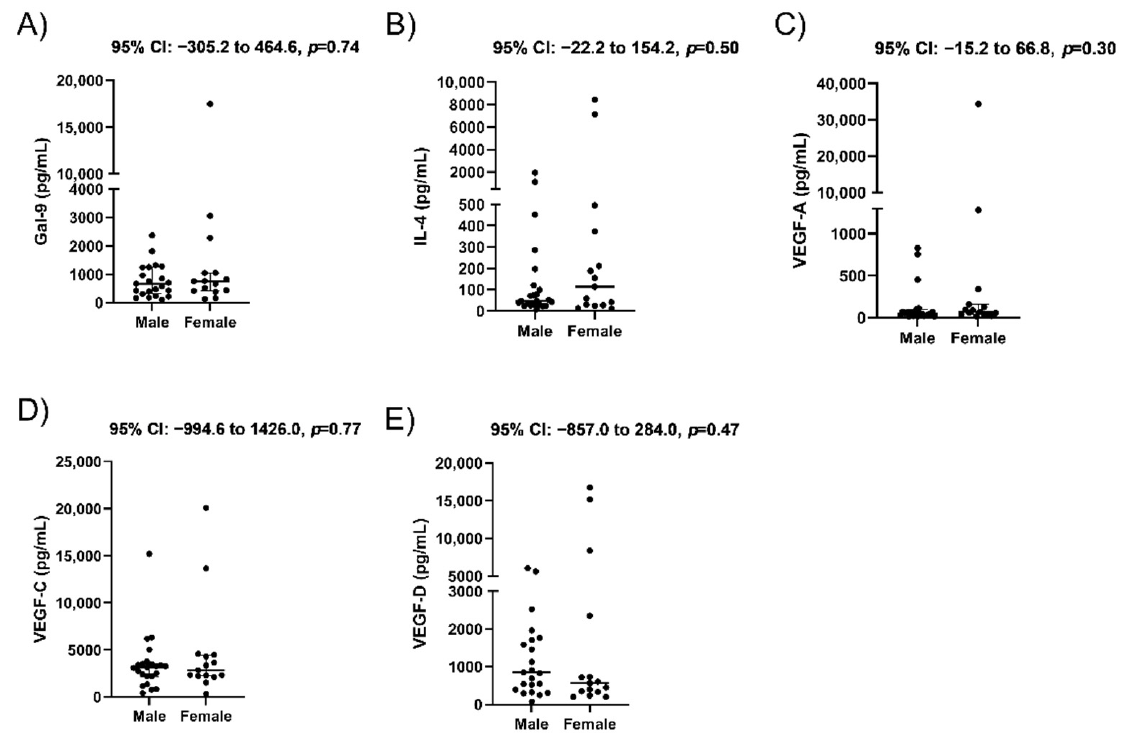
Figure 5. Maternal plasma concentrations based on fetal sex. Concentrations determined by ELISA for Galectin-9 ( A ), IL-4 ( B ), VEGF-A ( C ), VEGF-C ( D ), and VEGF-D ( E ) compared based on the sex of the fetus. Data are displayed as the median with interquartile range, along with 95% CI for the median difference between groups above each panel.